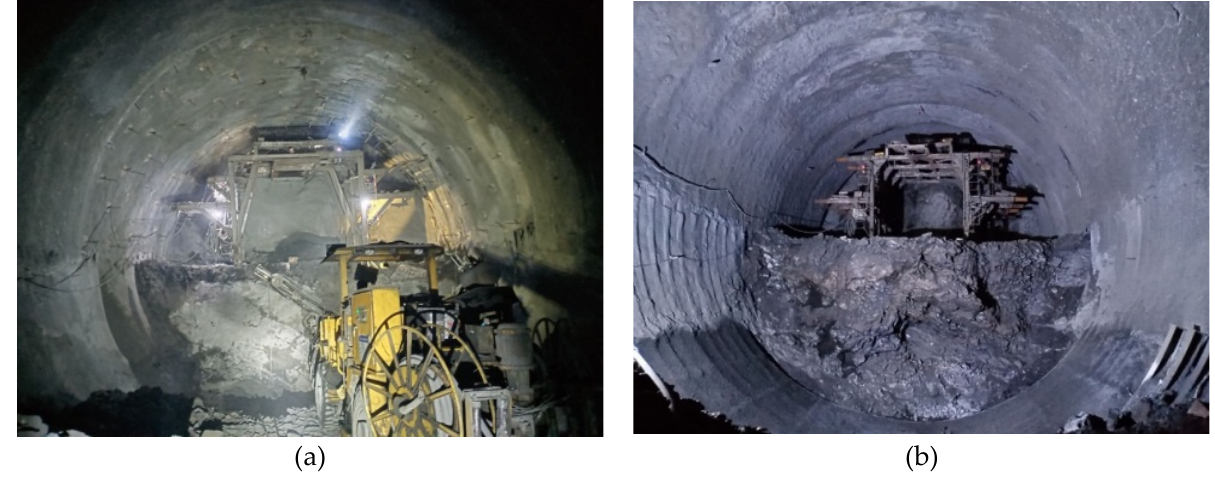
Figure 7. Diagrams showing the overall model and the tunnel section: ( a ) model size; ( b ) tunnel cross-section size.